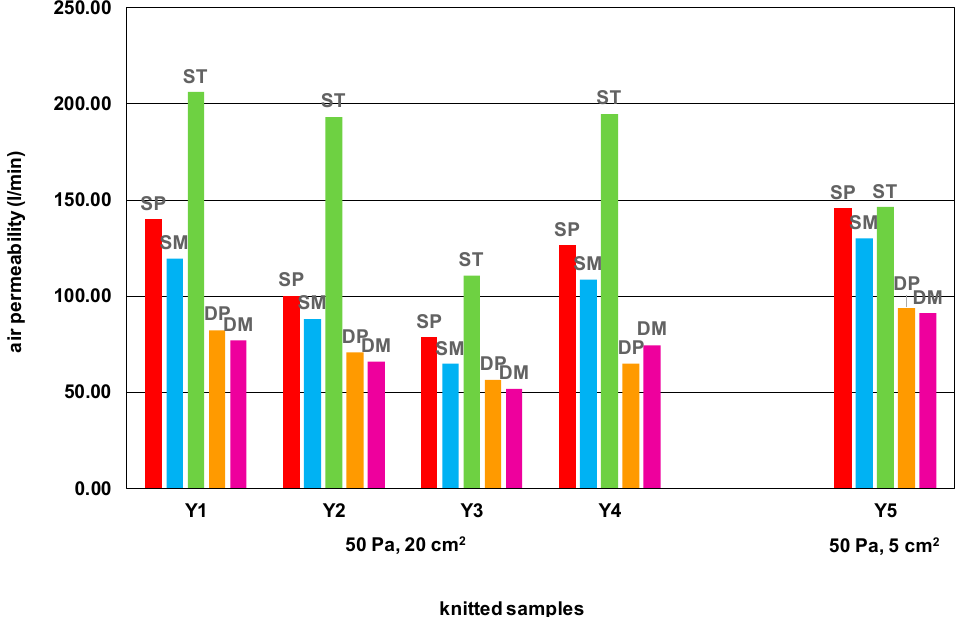
Figure 2. Air permeability of knitted samples in different single and double structures.